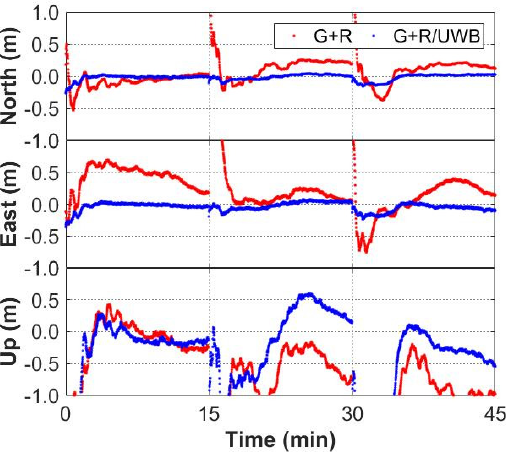
Figure 11. Convergence performance of GPS + GLONASS and GPS + GLONASS/UWB solutions